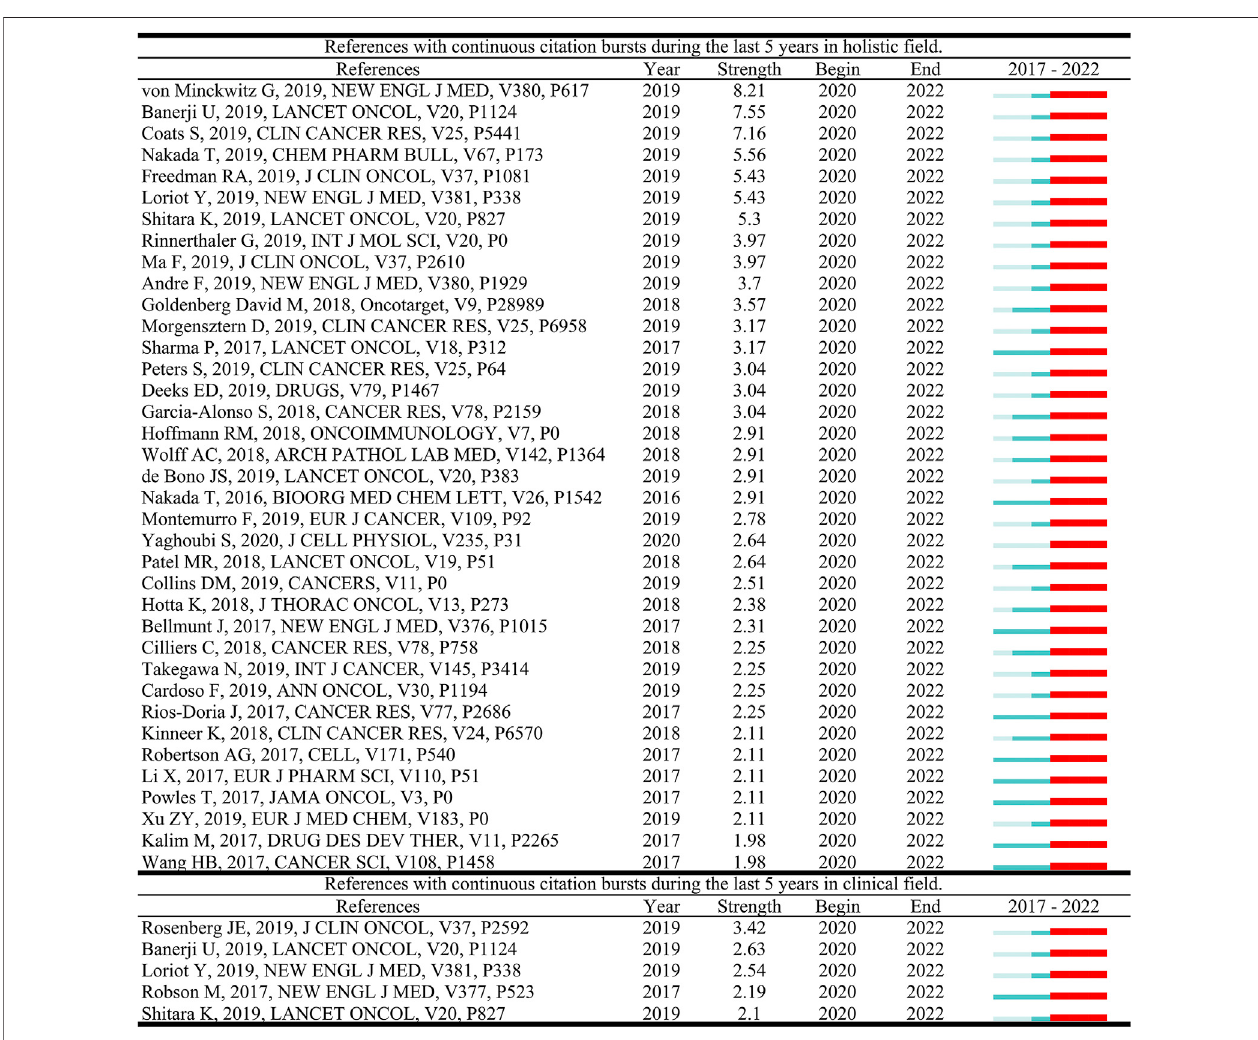
FIGURE 5 | References with continuous citation bursts during the last 5